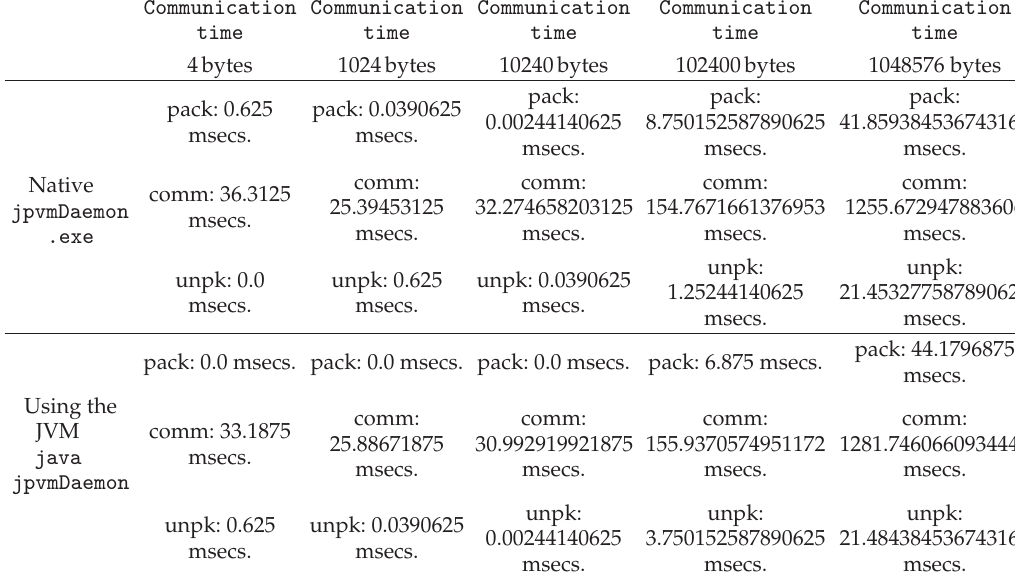
Table 2: Communication